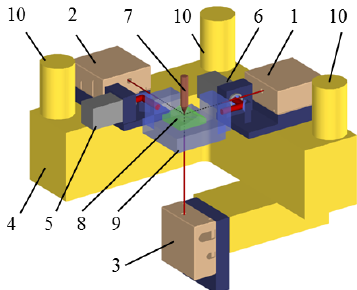
Figure 4. Principle design of the nanomeasuring machine: (1) x in- terferometer, (2) y interferometer, (3) z interferometer, (4) metrol- ogy frame made of Zerodur, (5) roll and yaw angular sensor, (6) pitch and yaw angular sensor, (7) surface-sensing probe, (8) sample, (9) mirror corner, and (10) fixing points for probe sys- tem.